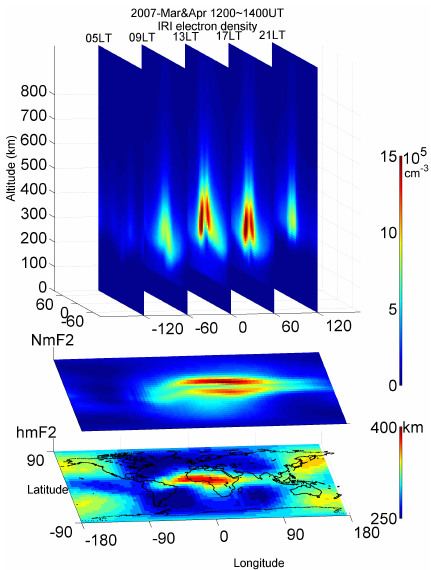
Figure 3. The OSSE truth. The median of IRI output obtained from 12:00–14:00UT in March and April of 2007. The electron density distribution, Nm F2, and hm F2 are shown from up to down.